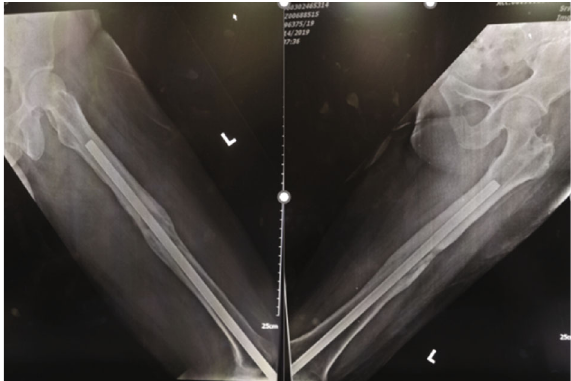
Figure 2: Plain radiograph shows the feature of chronic osteomyelitis over femur shaft.